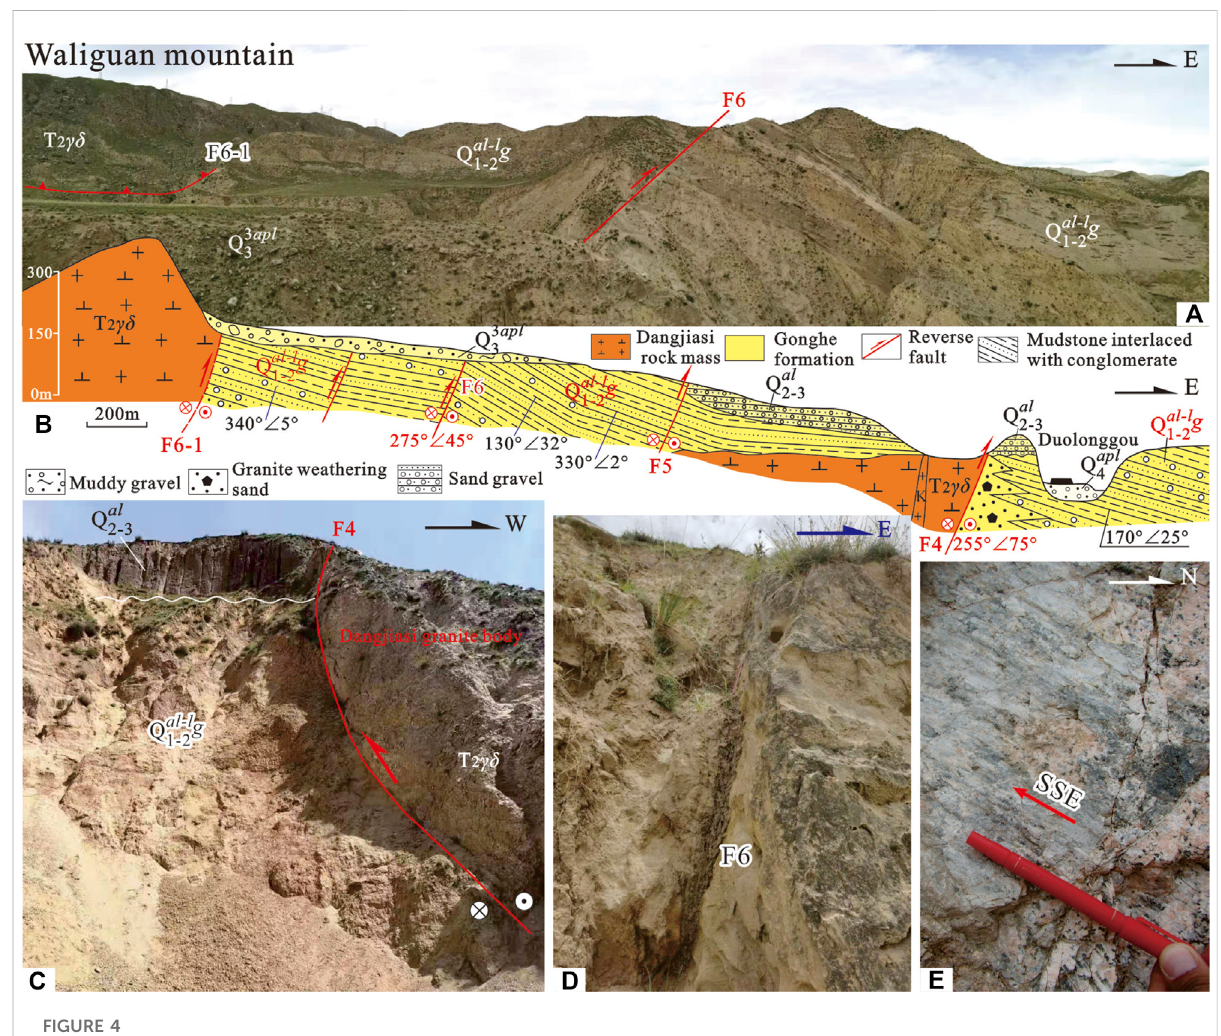
FIGURE 4 (A,B) Photo and pro fi le of the Chiqugou